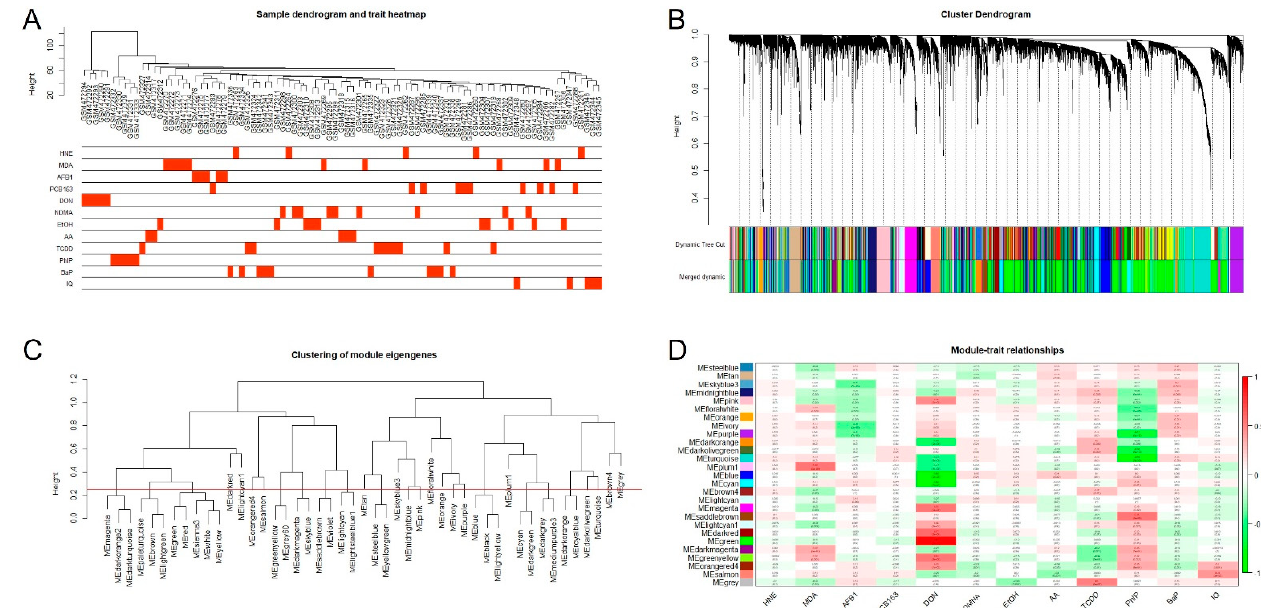
Figure 1. The WGCNA result of GSE19078. ( A ) The sample dendrogram and trait heatmap of GSE19078 (n sample = 89). The clustering dendrogram of samples was based on their Euclidean distance. ( B ) Identification of gene coexpression modules in GSE19078. ( A ) Clustering dendrogram of genes, with dissimilarity based on topological overlap, together with assigned merged module colors and the original module colors. ( B ) The Dynamic Tree Cut of original module colors. ( C ) To merge modules, the height cut was set at 0.25, corresponding to the correlation of 0.75. ( D ) The module-trait associations. Each row corresponds to a module eigengene, and column to a trait (treatment). Each cell contains the corresponding correlation Pearson r and p- value. The table is color-coded by the correlation according to the color. The correlation Pearson r value and the significance between gene modules and the clinical traits are available in Supplementary Table S2 and Supplementary Table S3, respectively. The full names for abbreviations of the 12 chemicals is available in Supplementary Table S4.